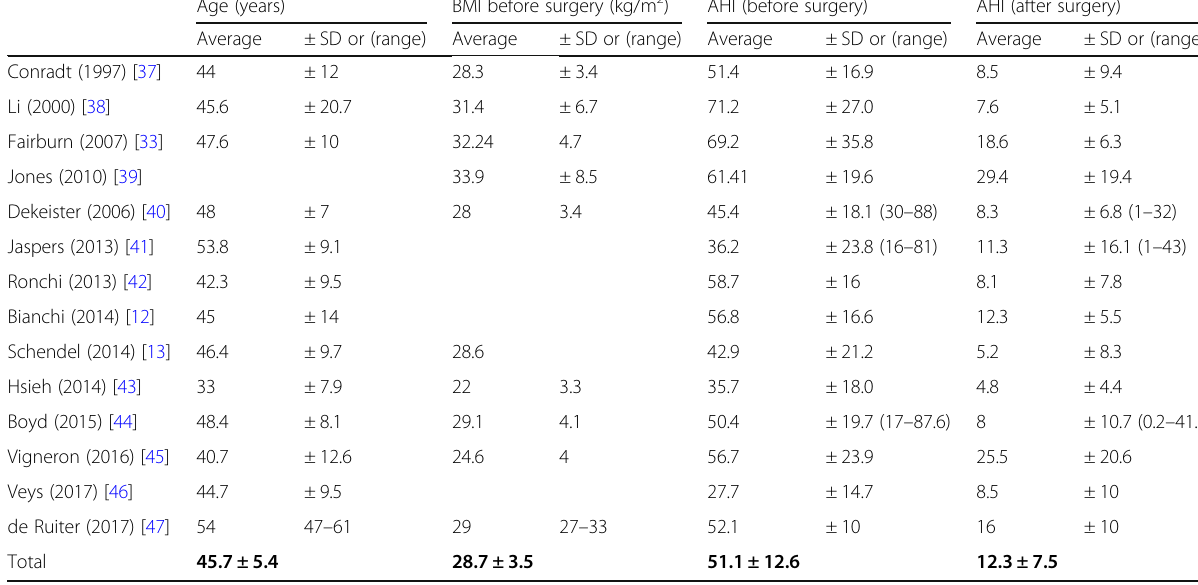
Table 5 Age, body mass index (BMI), and apnea-hypopnea index (AHI) of the studies investigating pharyngeal airway changes in maxillomandibular advancement